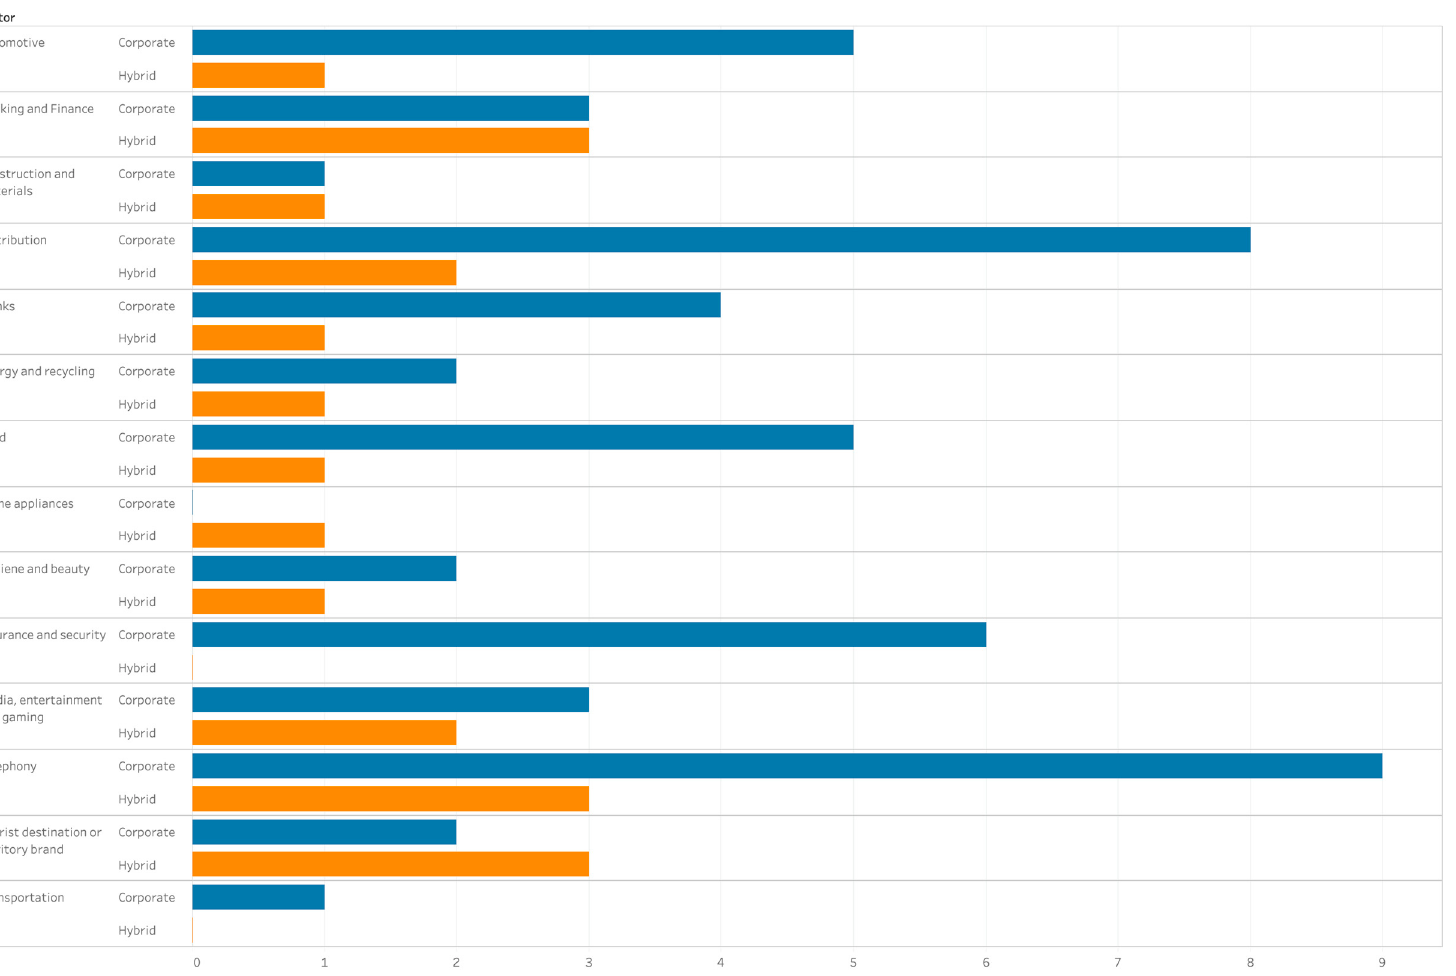
Figure 5. Typology of messages by sector.